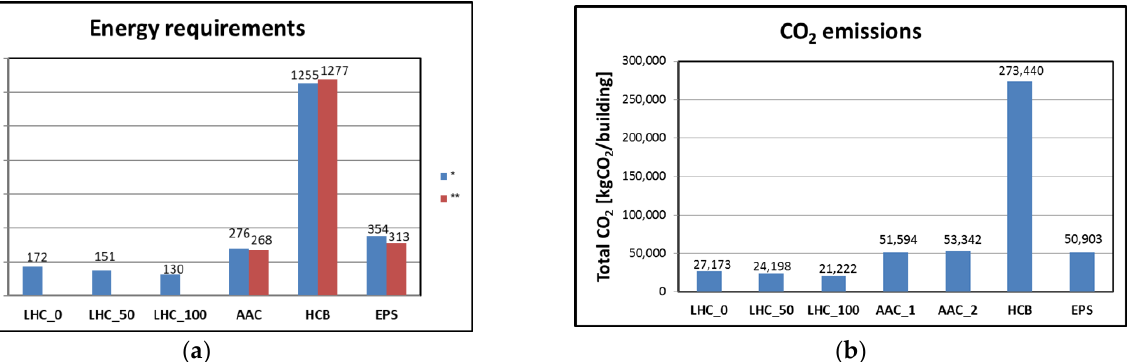
Figure 3. The buildings ’ total energy consumption and CO 2 emissions throughout its life cycle, for all LHC mixtures, as compared to conventional materials. ( a ) Energy requirements; ( b ) CO 2 emissions. * is based on [33], and ** is based [42].